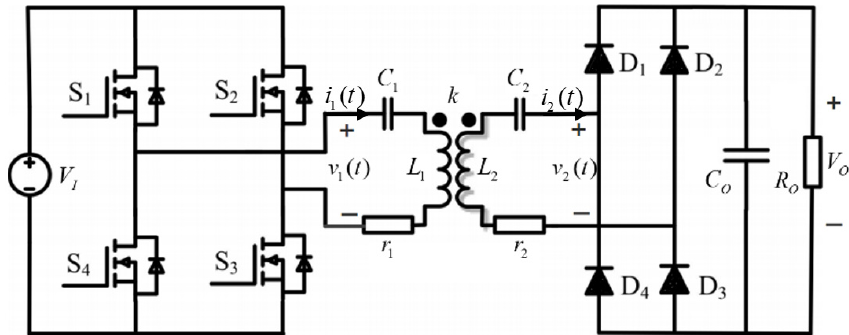
Figure 1. Series-series compensated inductive WPT link.